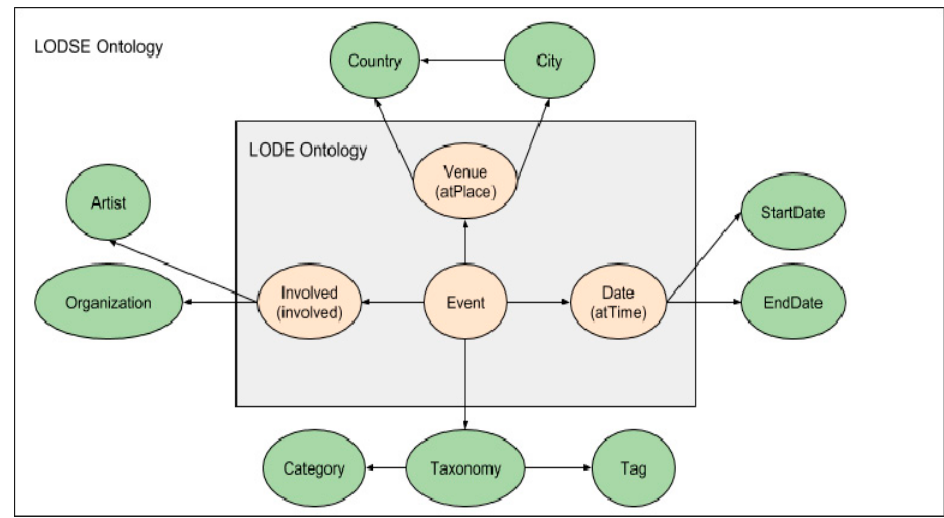
Figure 1. A comparison between linking open descriptions of events (LODE) ontology and linking open descriptions of social events (LODSE) ontology.